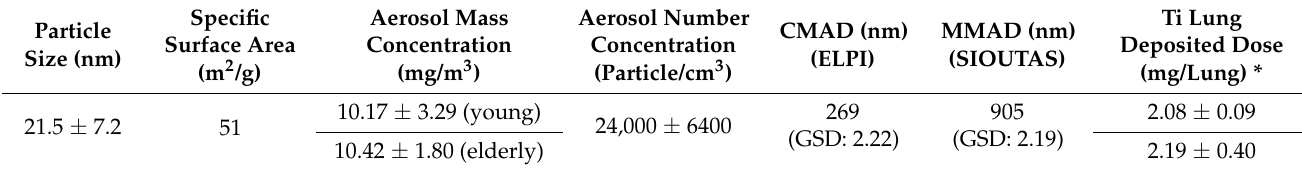
Table 1. Main titanium dioxide particle and aerosol